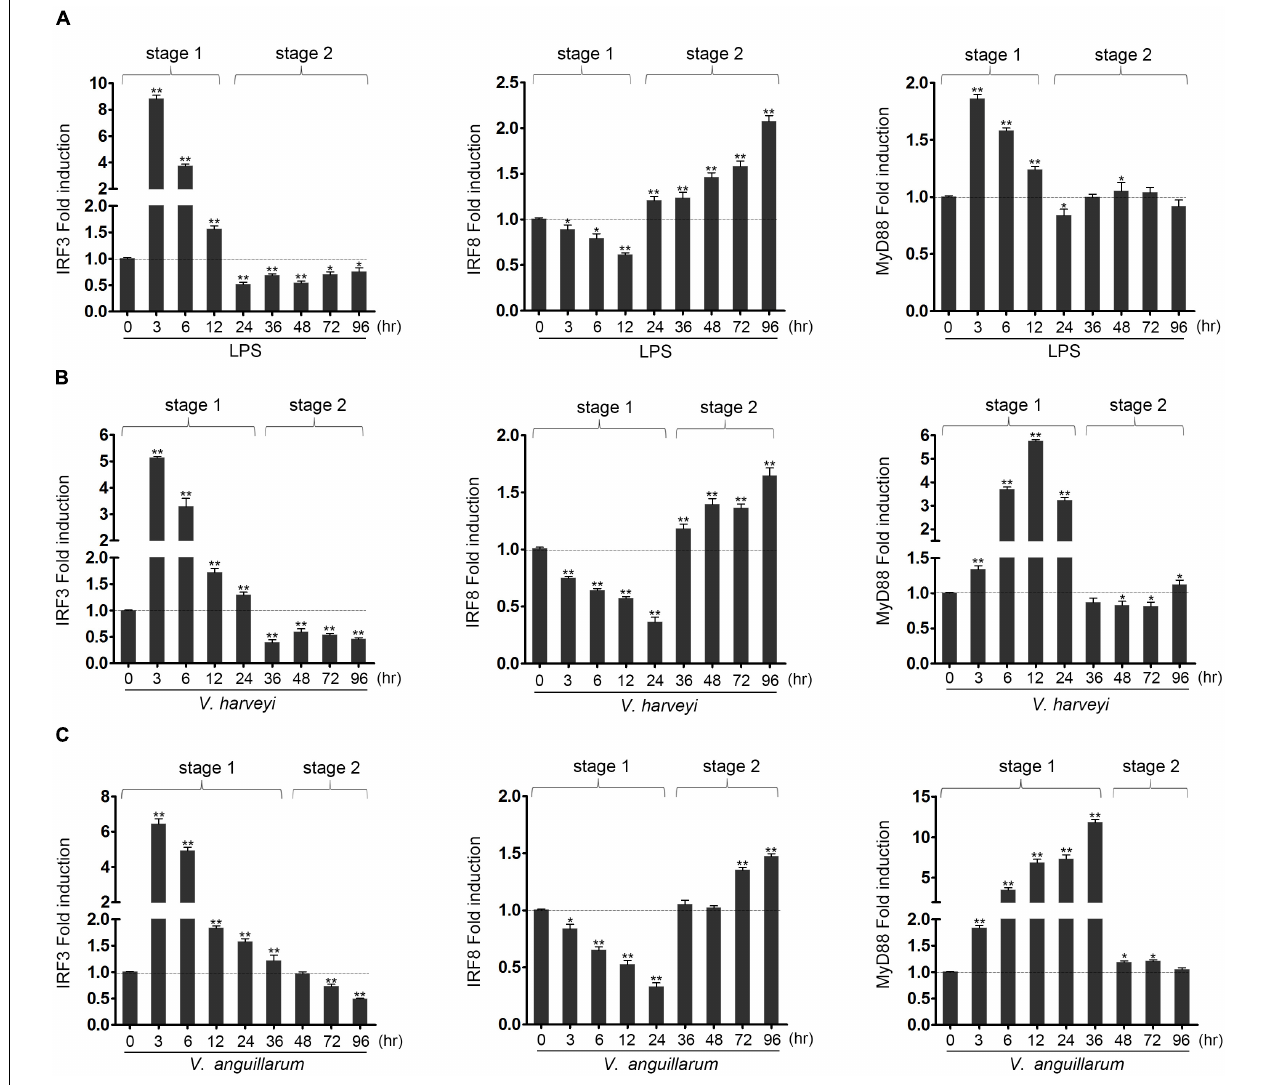
FIGURE 1 | The expression profiles of IRF3, IRF8 and MyD88 in liver after lipopolysaccharide (LPS) and Vibrio induction. The expression profiles of IRF3, IRF8, and MyD88 has been analyzed in liver at 3, 6, 12, 24, 36, 48, 72, and 96 h after induction with LPS (A) , as well as infected with Vibrio harveyi (B) or Vibrio anguillarum (C) . The total RNAs were extracted, and the expression of IRF3, IRF8, and MyD88 was examined by qRT-PCR. All experiments were performed in at least three independent experiments. * p < 0.05 and ** p < 0.01 versus the controls.